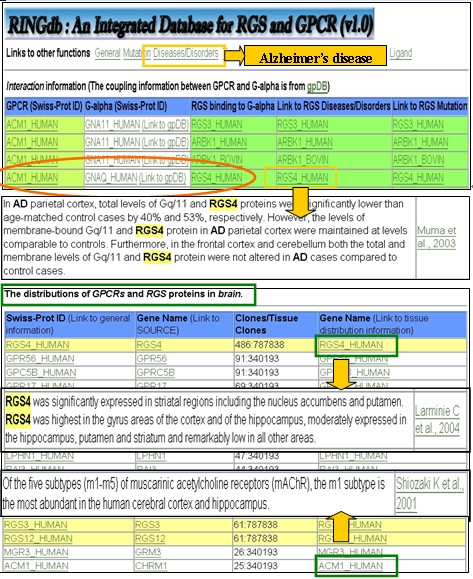
Inferring relationships among GPCRs, Gα and RGS proteins for specific disease states. The relationship among GPCR, Gα and RGS protein can be retrieved. The user can also find information regarding diseases that relate to such entries as well as information on their tissue distribution. Integrating the information presented above would be useful in inferring the relationship between RGS proteins and GPCRs.